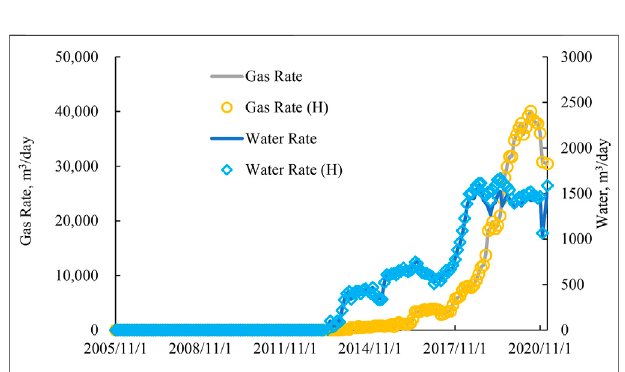
FIGURE6| Historymatchingofthedailygasandwaterproductioninthe upscaled model.